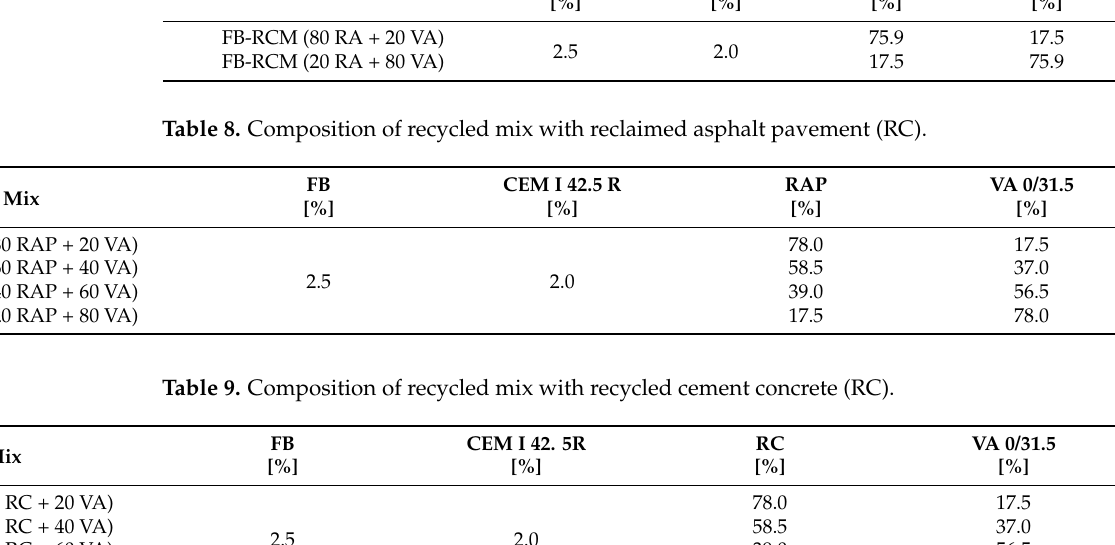
Figure 4. Gradation curve for FB-RCM with RA. Figure 5. Gradation curve for FB-RCM with RC. The next phase of the FB-RCM mix design process consisted of determining the op- timum moisture content (OMC). The optimum amount of water in the mineral mix was determined in accordance with standard PN-EN 13286-2 [47], using the proctored